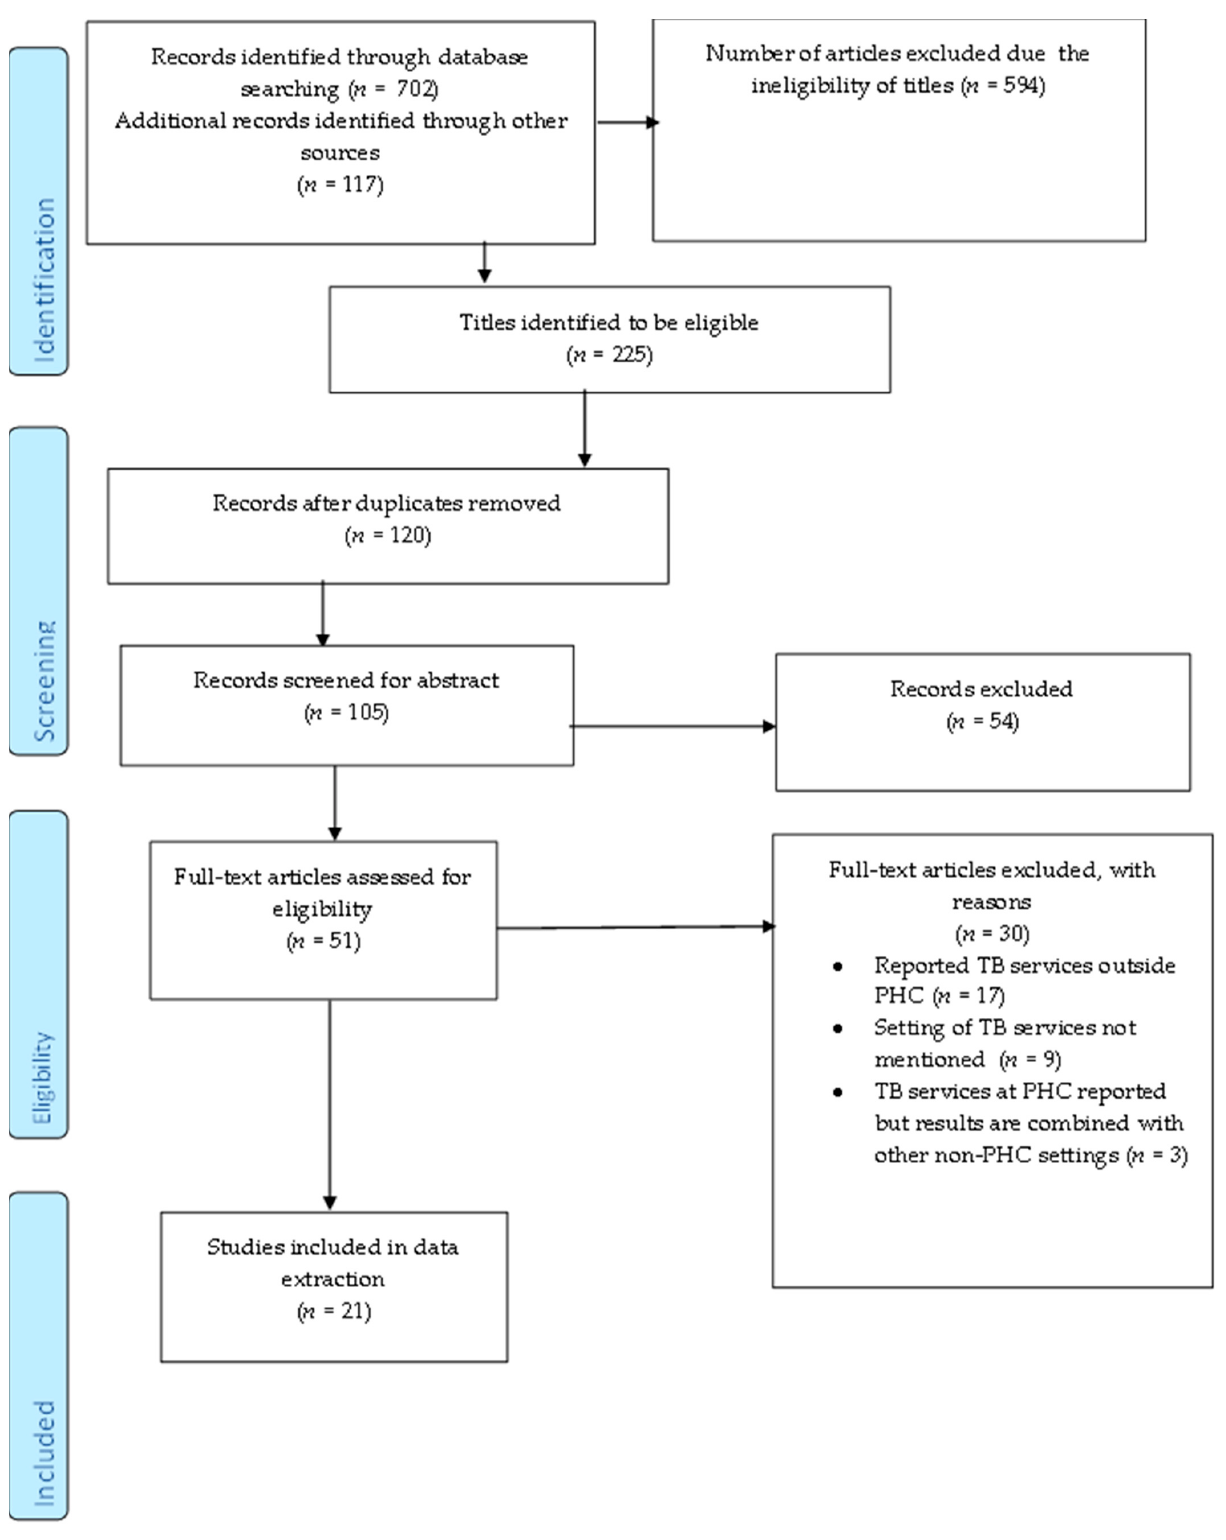
Figure 1. Prisma-flow diagram depicting the process of selecting and excluding studies.